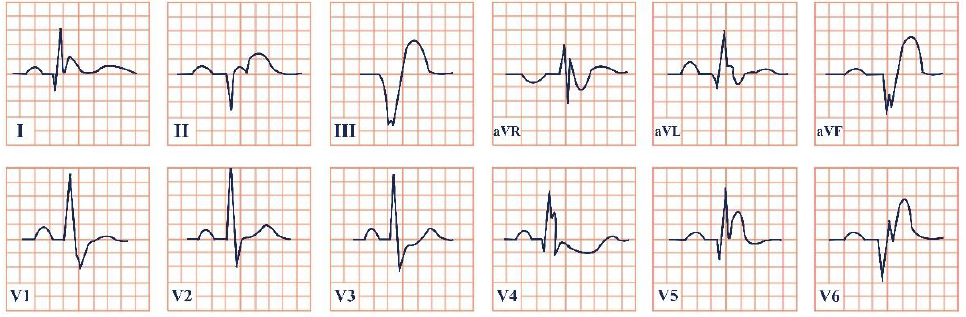
Figure 11. Electrocardiogram aspect in Haïssaguerre